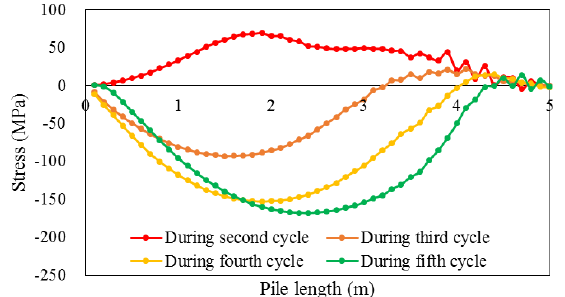
Figure 20. Variation in stress acting on Pile-1 during Stage 1 of each construction cycle at cover depth of 1.5 m.